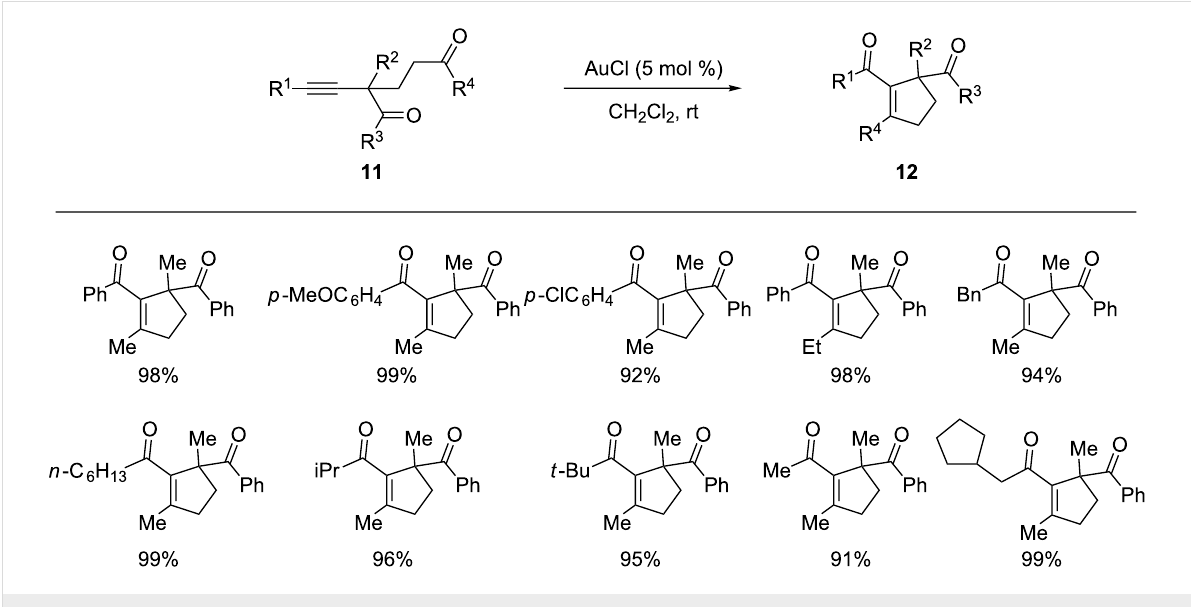
Scheme 7: Gold-catalyzed cyclizations of 2-alkynyl-1,5-diketones.